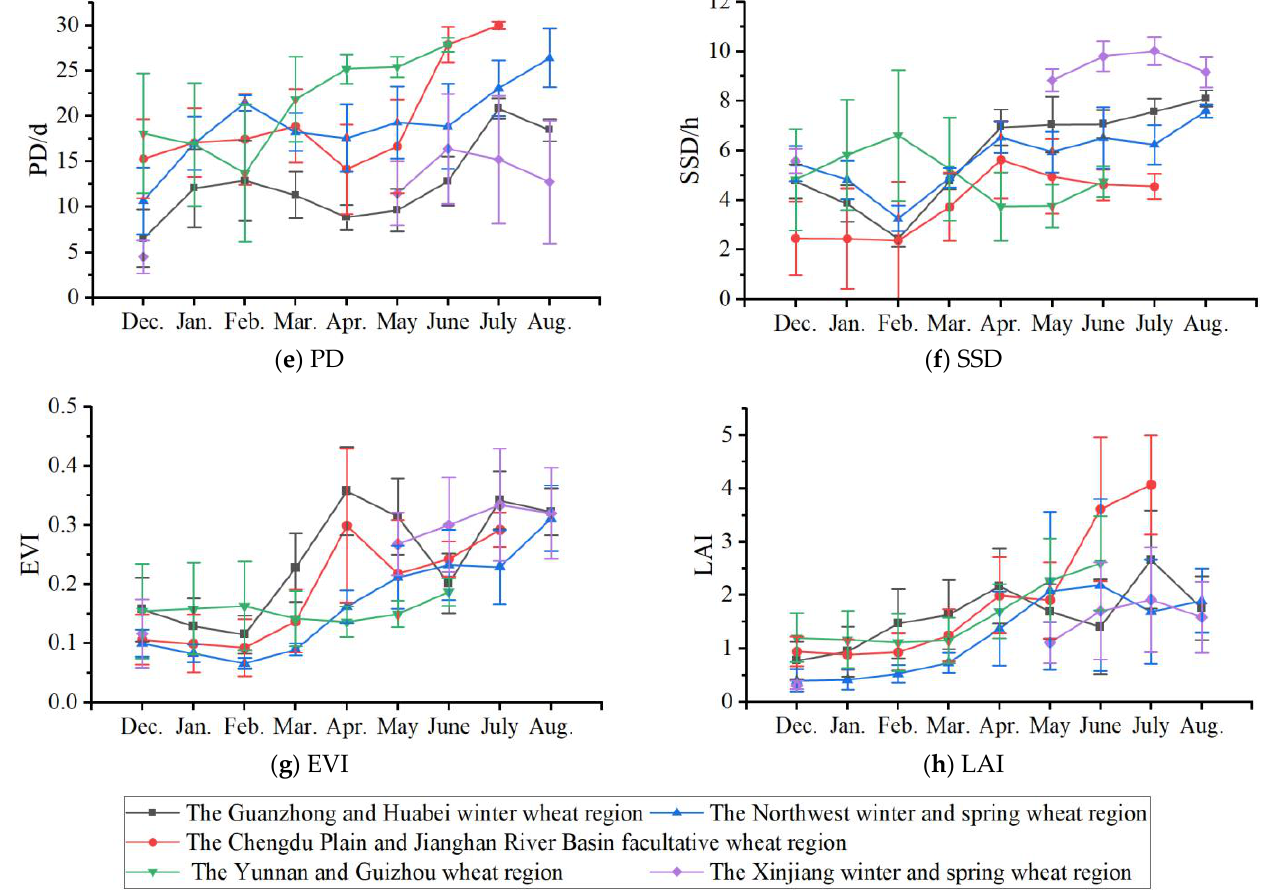
Figure 7. The mean and standard deviation of environmental variables in high-potential areas of major stripe rust ecological zones; ( a – h ) represent different environmental variables.